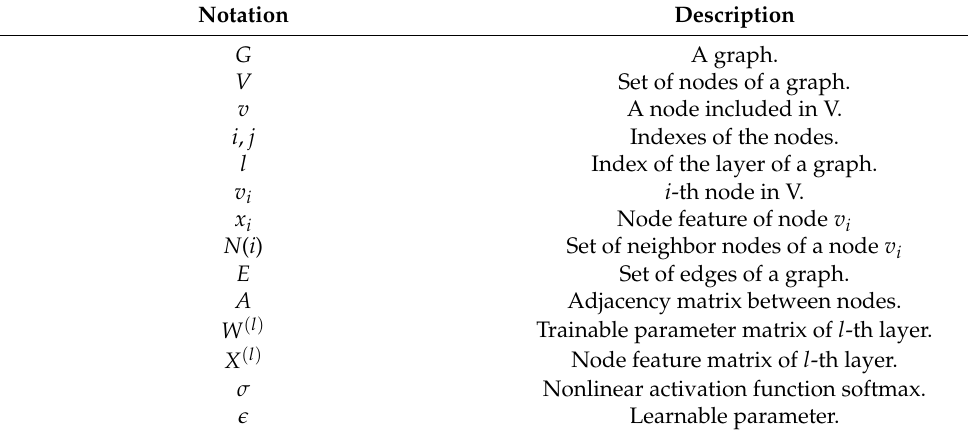
Table 5. Notation of graph neural networks used in this